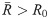
Sketch of a large solid sphere of radius R0 enclosed in a narrow fluctuating membrane tube.The undeformed section of membrane tube has a radius r0 ≪ R0, while the highly deformed portion of membrane enclosing the solid sphere possesses (on average) a radius of R¯>R0 due to membrane fluctuations. The degree of wrapping of the solid sphere by the enclosing membrane is characterised by the angle Δθ ≪ 1. (Membrane fluctuation extent shown is exaggerated, for purposes of illustration).